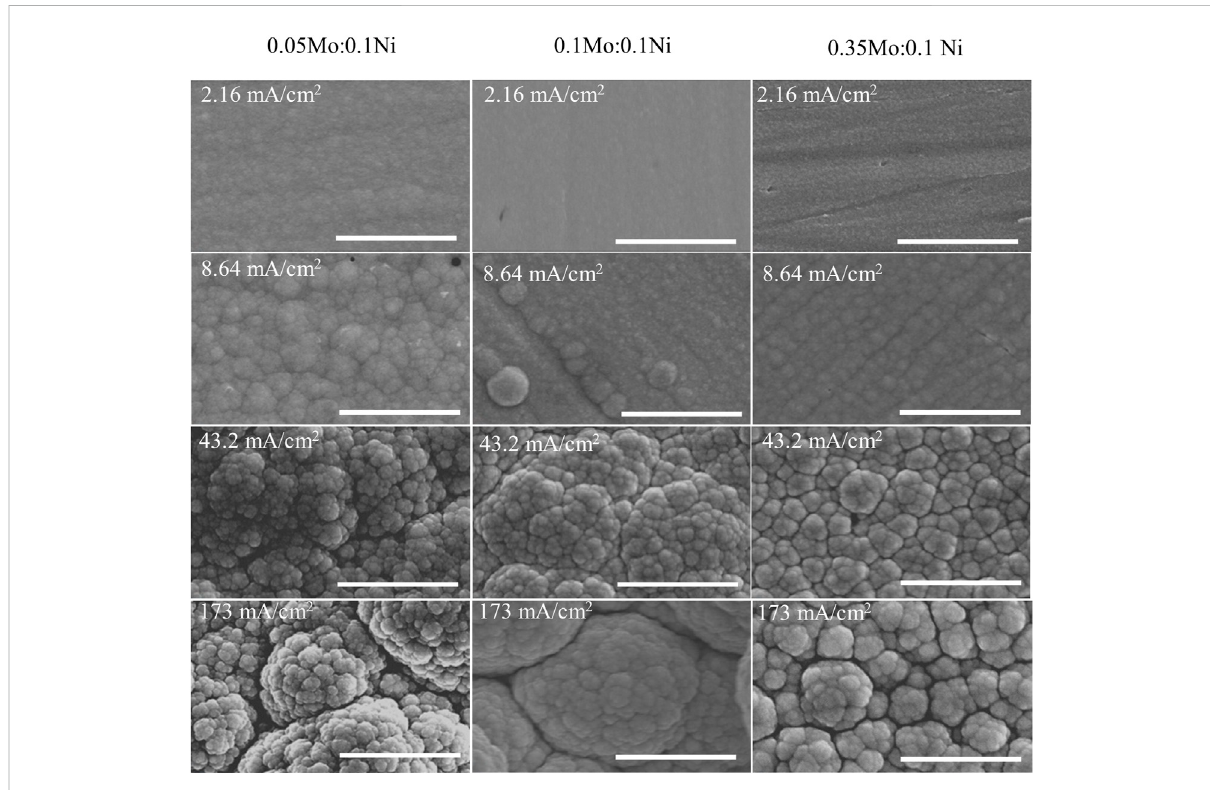
SEM images of deposits at various Mo-to-Ni molar ratio and current density at fi xed 0.1 M Ni 2+ , 0.05 M Cit 3 − , and 0.2 M NH 4 +. Scale bar: 3